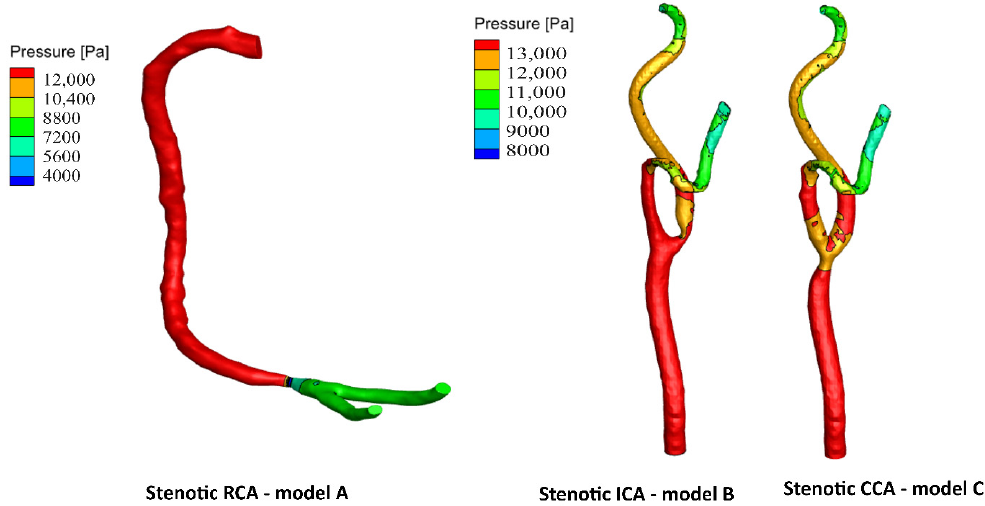
Figure 13. Pressure distribution for the wall compliance models at the peak systole of the cardiac cycle.